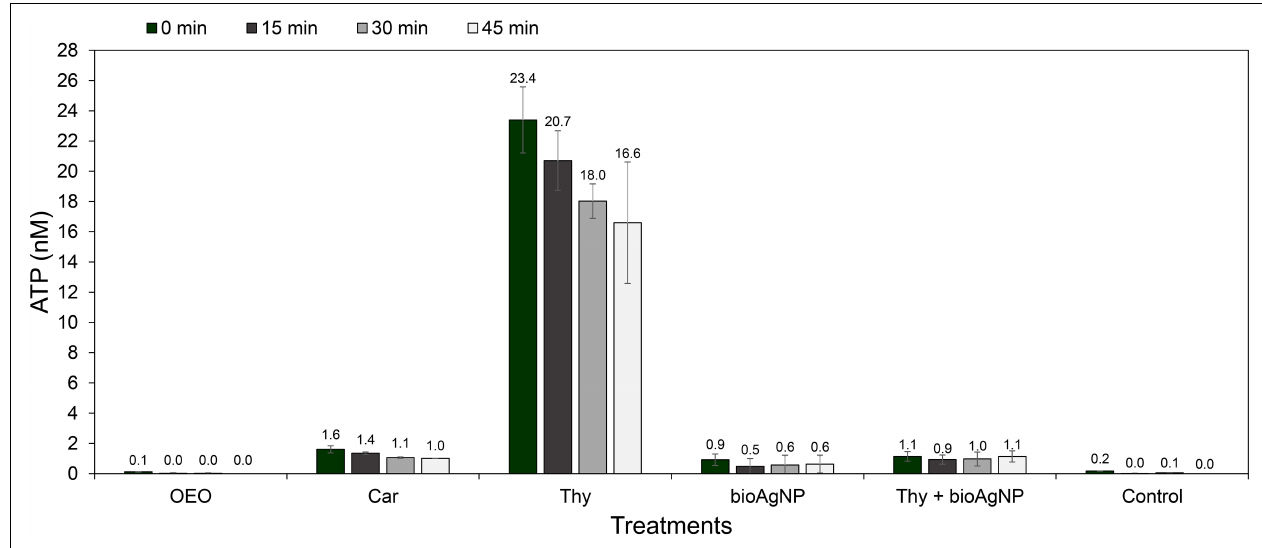
FIGURE 4 | Extracellular ATP concentrations over the time of E. coli ATCC 25922 exposed to the oregano-derived antimicrobials and bioAgNP individually and in combination at subinhibitory doses. Control indicates ATP leakage from untreated bacterial sample. ATP levels were measured at four time points of treatment: 0-h time point, after 15 min of treatment, after 30 min of treatment, and after 45 min of treatment. Values of ATP (nM) are the mean ± standard deviation.